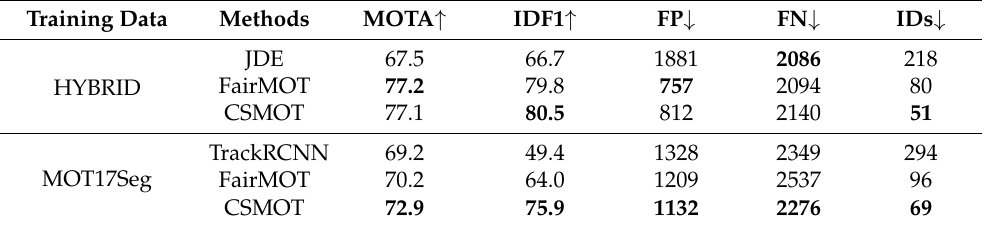
Table 6. Comparison of the advanced one-shot algorithms on the 2DMOT15 validation set. “HYBRID” represents the large-scale training dataset. “MOT17Seg” stands for the four videos with segmentation labels in the MOT17 dataset. The best results of the same training data are shown in bold .